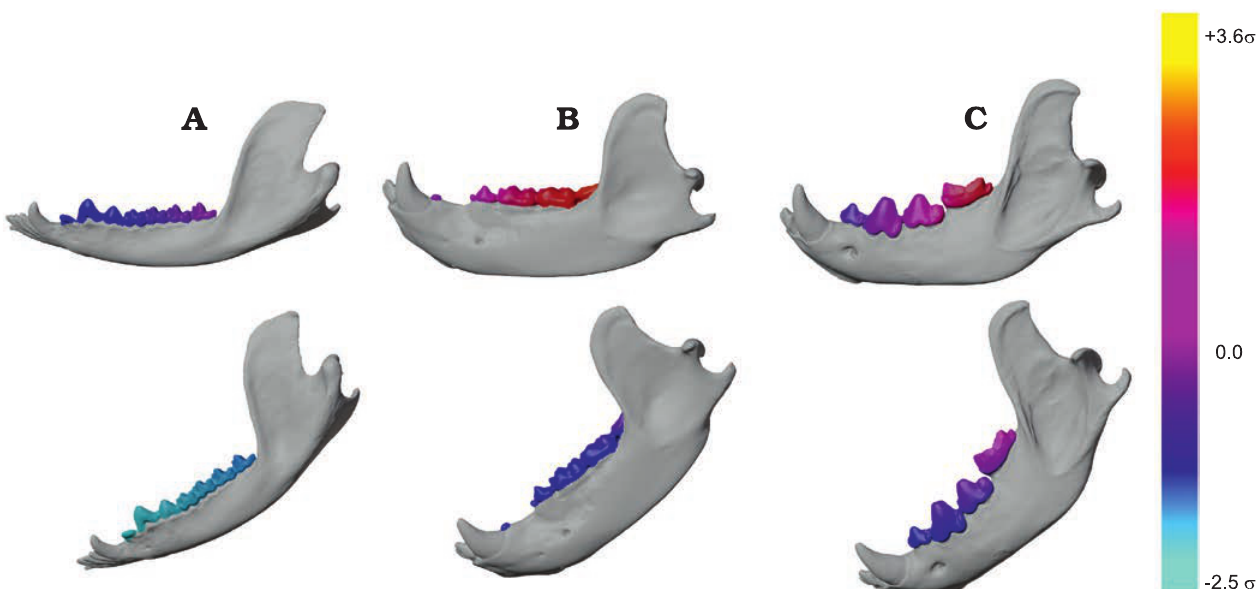
Fig. 12. Comparison of orthal bite force (BF) distribution across lower tooth-row at closed gape (CG) and open gape (OG). A . Didelphis marsupialis Linnaeus, 1758, a generalized mammal showing relatively low orthal BF magnitudes at both CG and OG. B . Ursus arctos Linnaeus, 1758, which shows very little ability to preserve high orthal BF at high gape among the therians sampled, but has very high orthal BF at CG. C . Crocuta crocuta (Erxleben, 1777), a taxon capable of preserving a large amount of orthal BF at high gape, and showing similar orthal BF values at CG and OG. Color bar at right is scaled to units of the combined (across-taxa) sample standard deviation in estimated orthal bite force values (generated using all muscle categories, see text). Therefore, colors within the postcanine toothrow correspond to matching, size-scaled, orthal BF magnitudes across all sampled taxa (and in Peligrotherium tropicalis as seen in Fig.